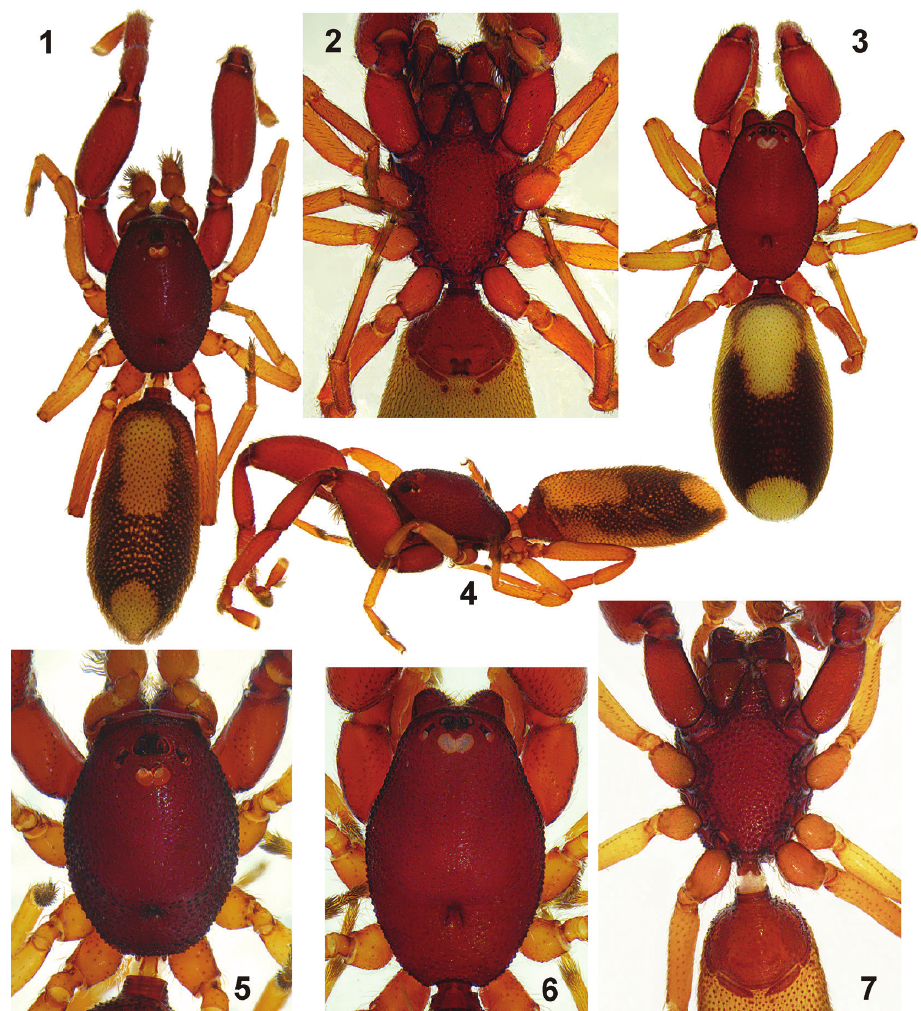
Figures 1–7. Habitus of Diaphorocellus biplagiatus male ( 1, 4–5, 7 ) and female ( 2–3, 6 ). 1, 3 entire body, dorsal 2, 7 prosoma and anterior part of abdomen, ventral 5–6 prosoma, dorsal.